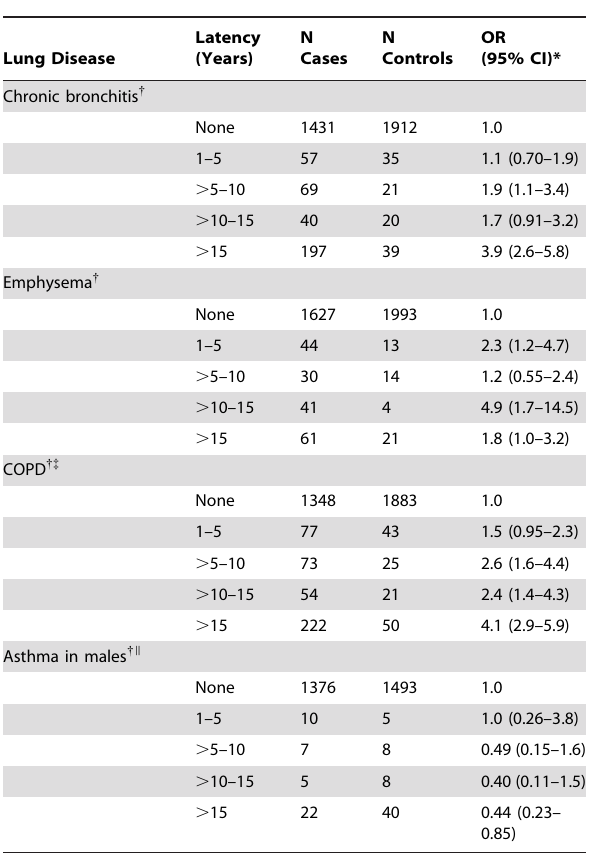
Table 5. Distributions of cases and controls from the Environment And Genetics in Lung cancer Etiology study and associations of lung cancer with lung disease diagnosed at least one year prior, stratified by time since diagnosis of lung disease